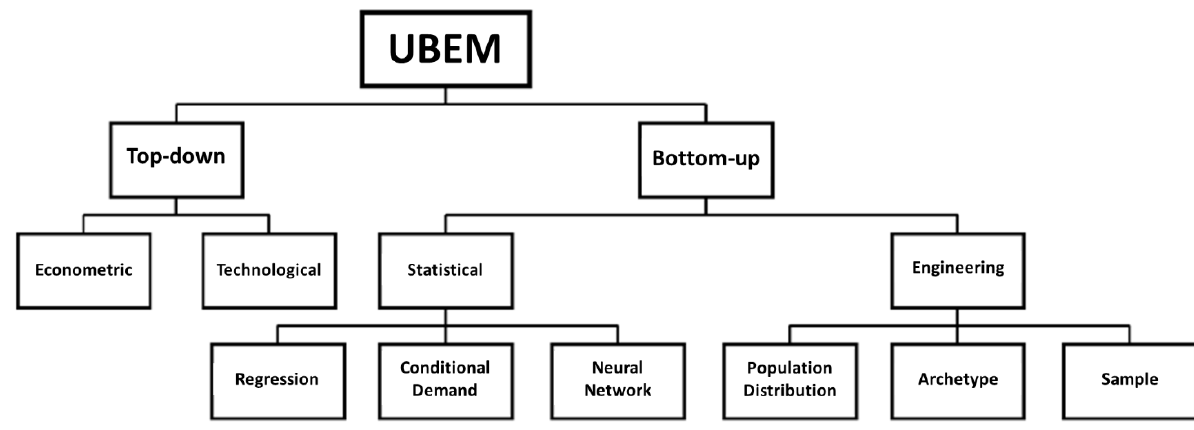
Figure 1. Schematic of the UBEM techniques [25].